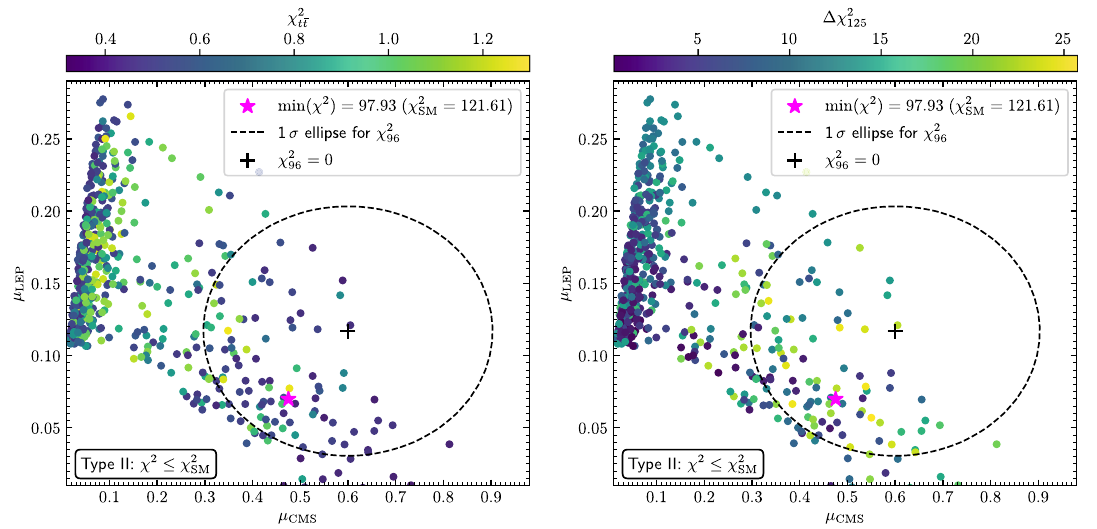
Fig. 7 The μ CMS – μ LEP plane for the points of the low tan β scan in the type II of the N2HDM. The black ellipse indicates the 1 σ region of χ 2 with its center marked with a black cross. The best-fit point is 96